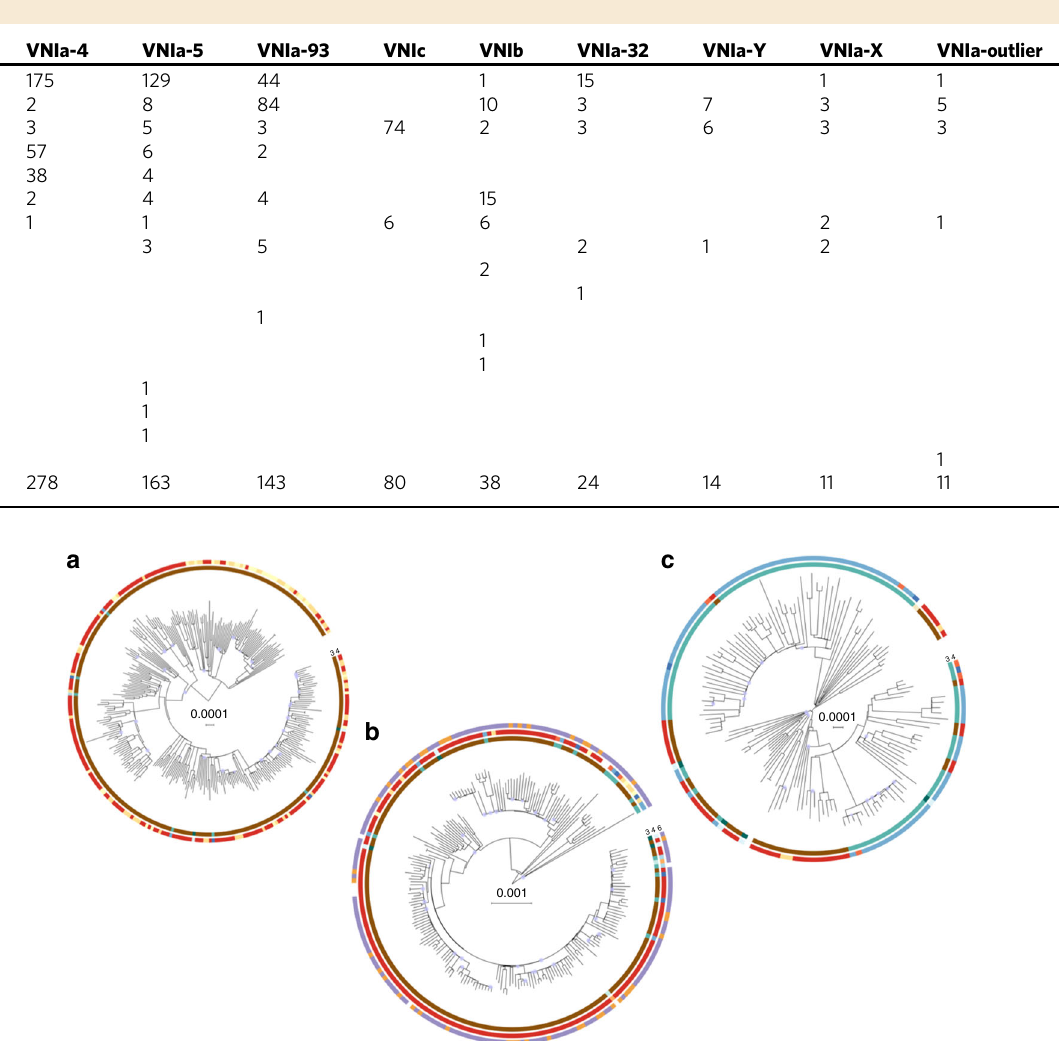
Table 1 Frequency of isolation of VNI sub-clades from HIV-infected patients in each country from both this study and Desjardins et al. 8